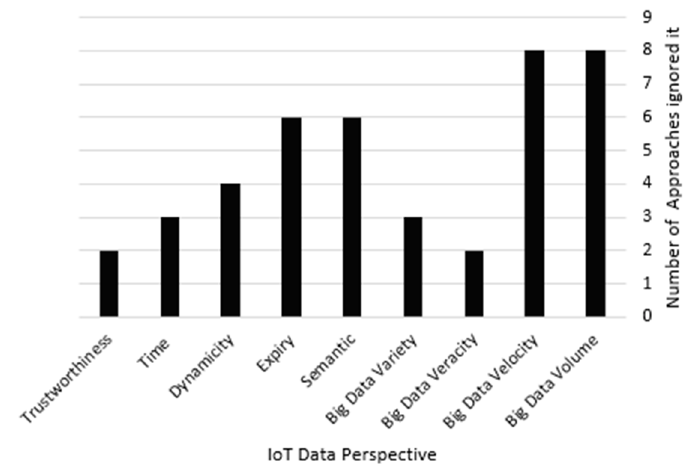
Figure 15. Evaluation of IoT data perspectives.